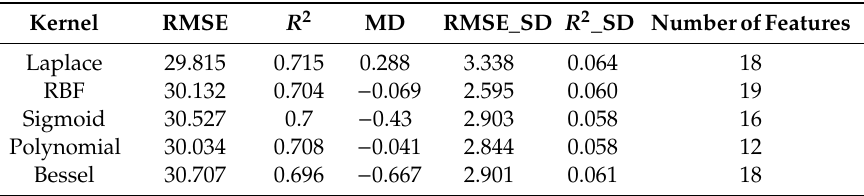
Table 10. Modeling optimized feature sets for each